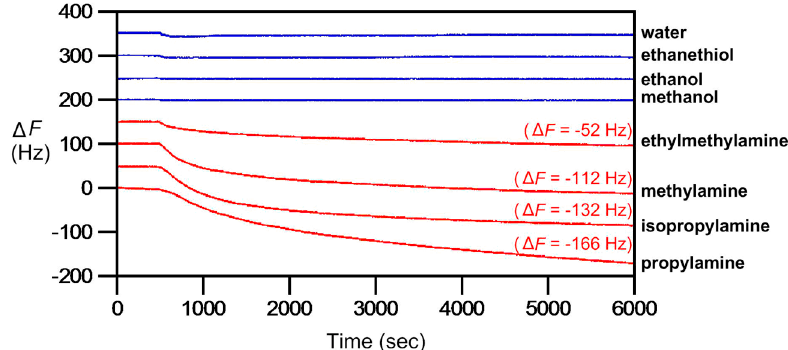
Figure 11. Chemoselective detection of water, ethanethiol, ethanol, methanol, ethylmethylamine, methylamine, isopropylamine and propylamine gases (100 ppb each) by 9 MHz QCM thin-coated with AIL6 . The carrier gas had a flow rate of 3 mL/min and the analytes were injected at 500 s. The sensorgrams above propylamine were purposely shifted vertically (50 Hz in between) for clarity.